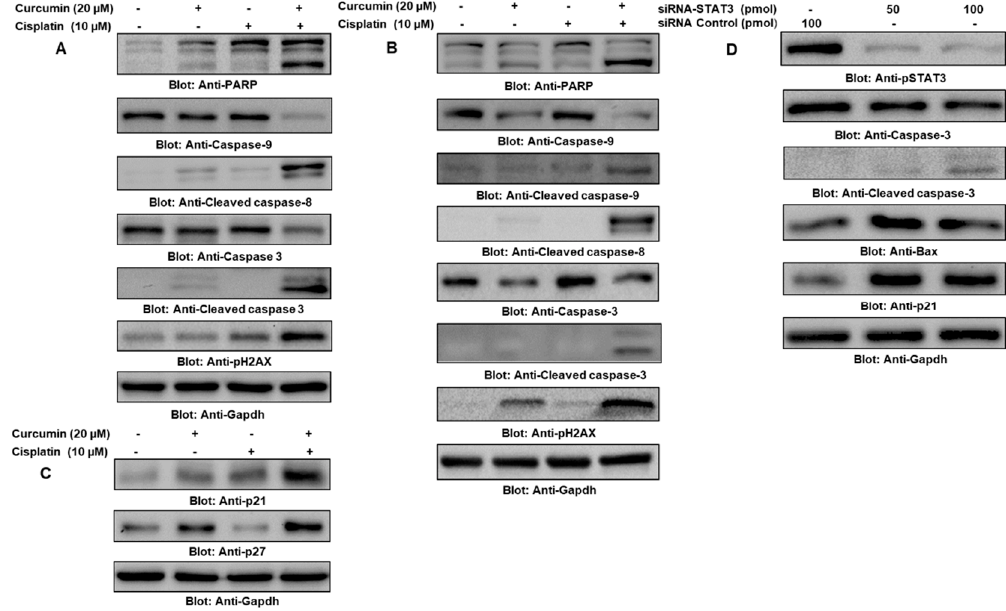
Figure 6. Cotreatment of curcumin with cisplatin-enhanced apoptosis of PTC cells via STAT3 downregulation. Curcumin potentiated cisplatin-induced growth arrest and inhibited the proliferation of BCPAP ( A ) and TPC-1 ( B ) cells through apoptosis. PTC cells were cultured and treated with 0 µ M or 20 µ M of curcumin and 10 µ M of cisplatin alone and in combination for 24 h. Cells were lysed and separated using SDS-PAGE, transferred to a PVDF membrane, and immunoblotted with antibodies such as caspase-9, cleaved caspase-9, cleaved caspase-8, caspase-3, cleaved caspase-3, PARP, p-H2AX, and Gapdh. ( C ) Curcumin synergistically potentiated cisplatin-induced growth inhibition by stimulating the expression of cyclin-dependent kinase inhibitor proteins (CDKIs) in PTC cells. BCPAP cells were treated with 0 µ M and 20 µ M of curcumin and 10 µ M of cisplatin alone and in combination for 24 h, followed by cell lysis and immunoblotting. Equal amounts of proteins were separated using SDS-PAGE, transferred to a PVDF membrane, and immunoblotted with antibodies against p27, p21, and Gapdh. ( D ) The e ff ect of siRNA-mediated knockdown of STAT3 on p-STAT3, CDKIs, and caspases. BCPAP cells were transfected with either control (100 pmol) or STAT3-specific siRNA (50 or 100 pmol). Cell extracts were separated using SDS-PAGE, transferred to a PVDF membrane, and immunoblotted with antibodies against p-STAT3, caspase-3, cleaved caspase-3, Bax, p21, and Gapdh.